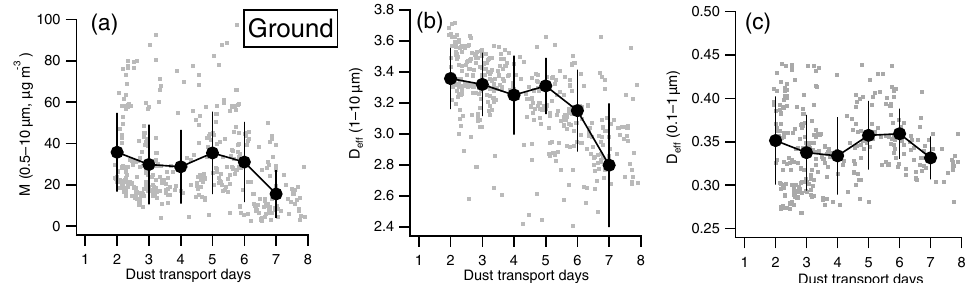
Figure 16. The particle mass and size as a function of dust transport time for the ground experiment, NB. D eff (1–10µm) is curtailed at 10µm compared to 20µm in Fig. 15.